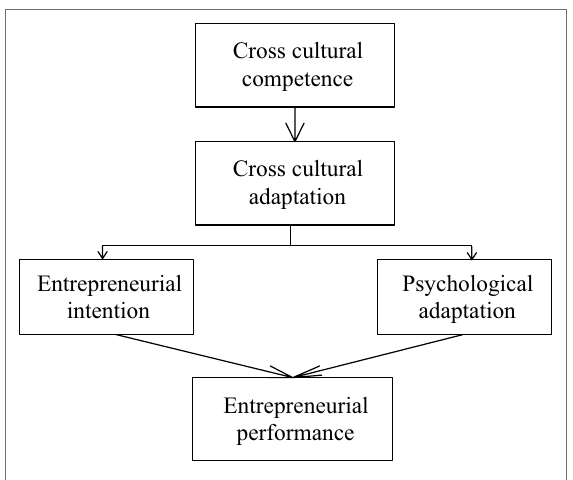
FIGURE 4 | Research framework of cross-cultural